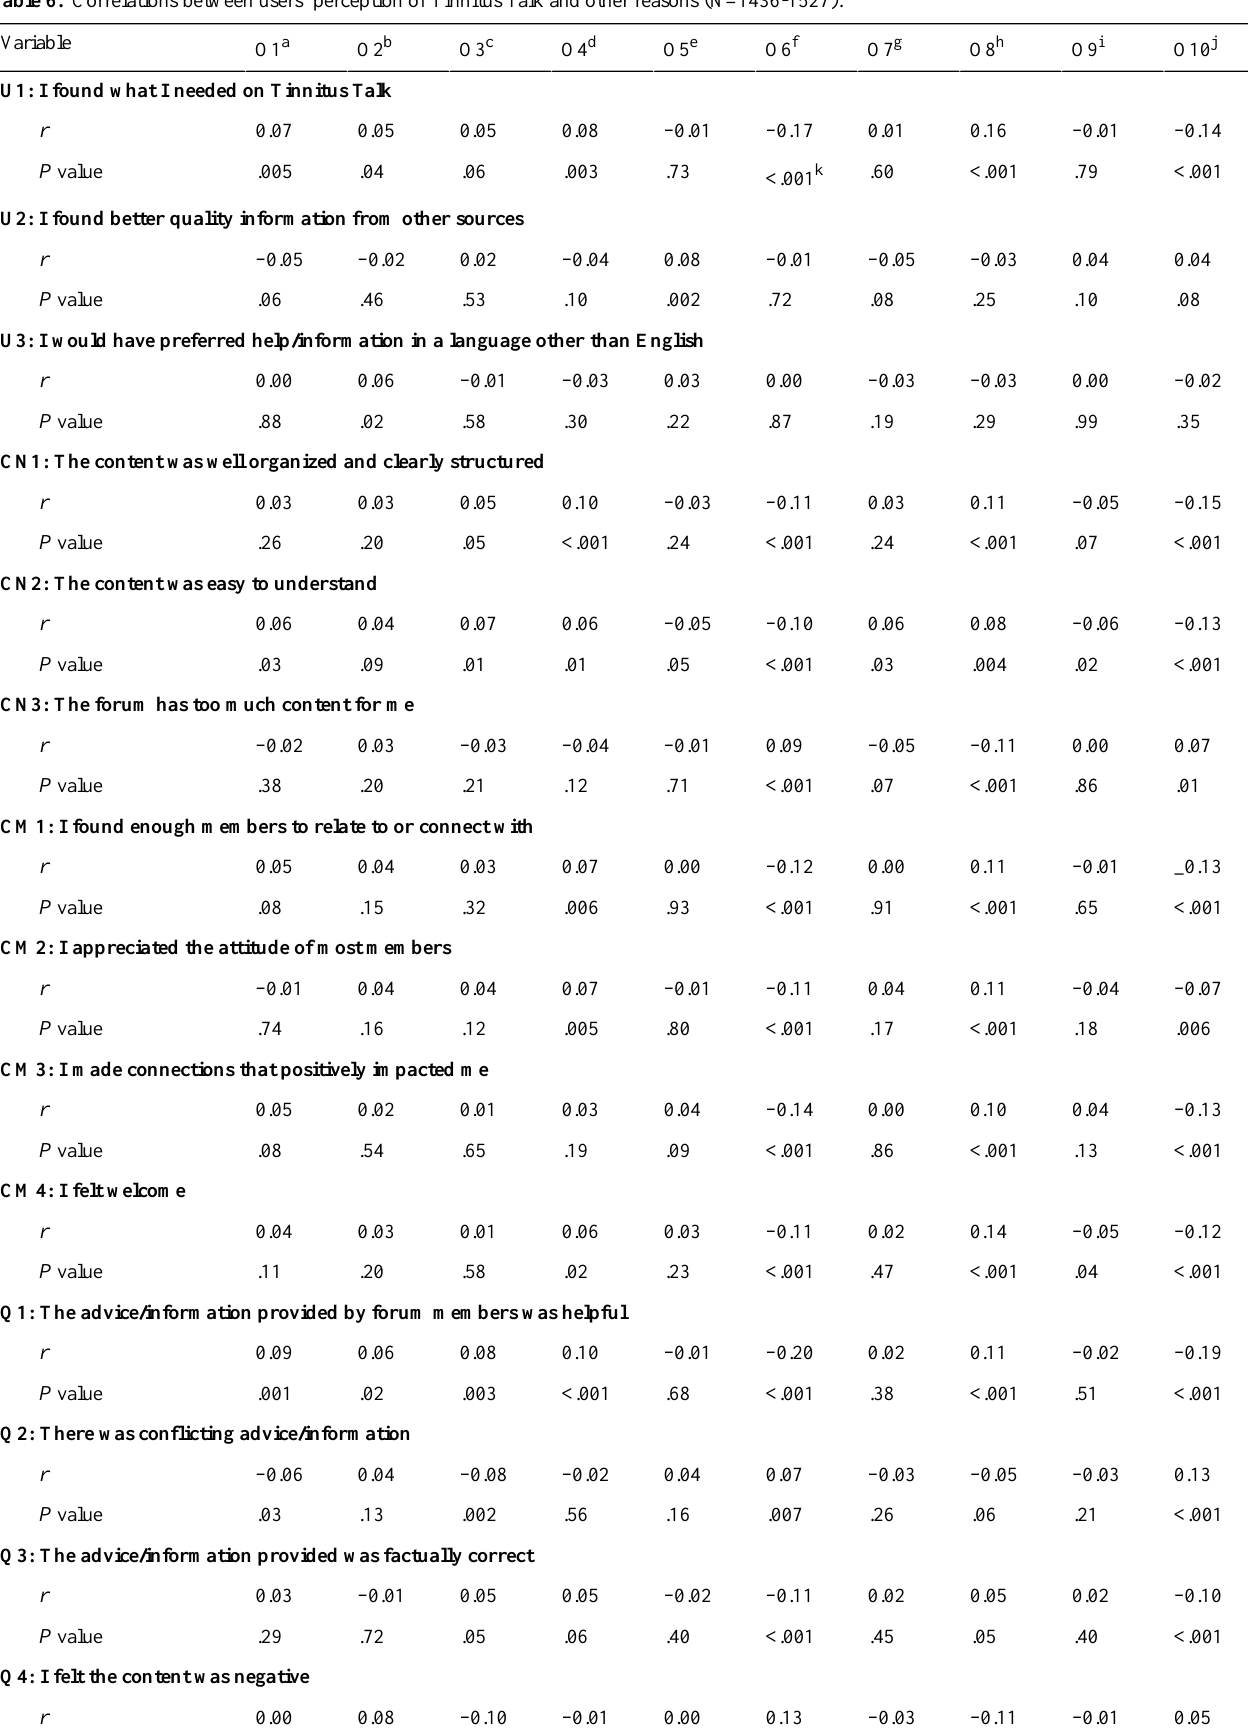
Table 6. Correlations between users’perception of Tinnitus Talk and other reasons